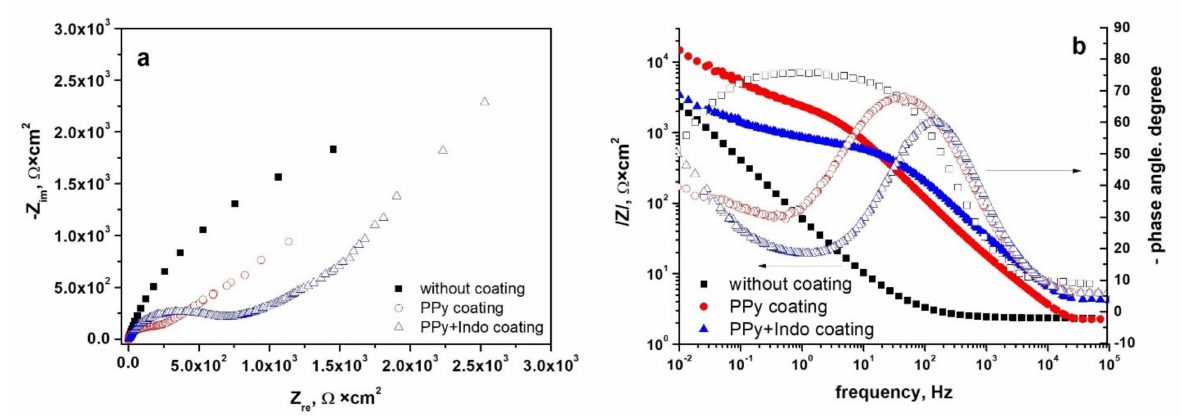
Figure 7. Nyquist ( a ) and Bode ( b ) diagrams for uncoated and PPy or PPy-Indo coated WBC type CoCr based alloys in Tani-Zuchi artificial saliva.